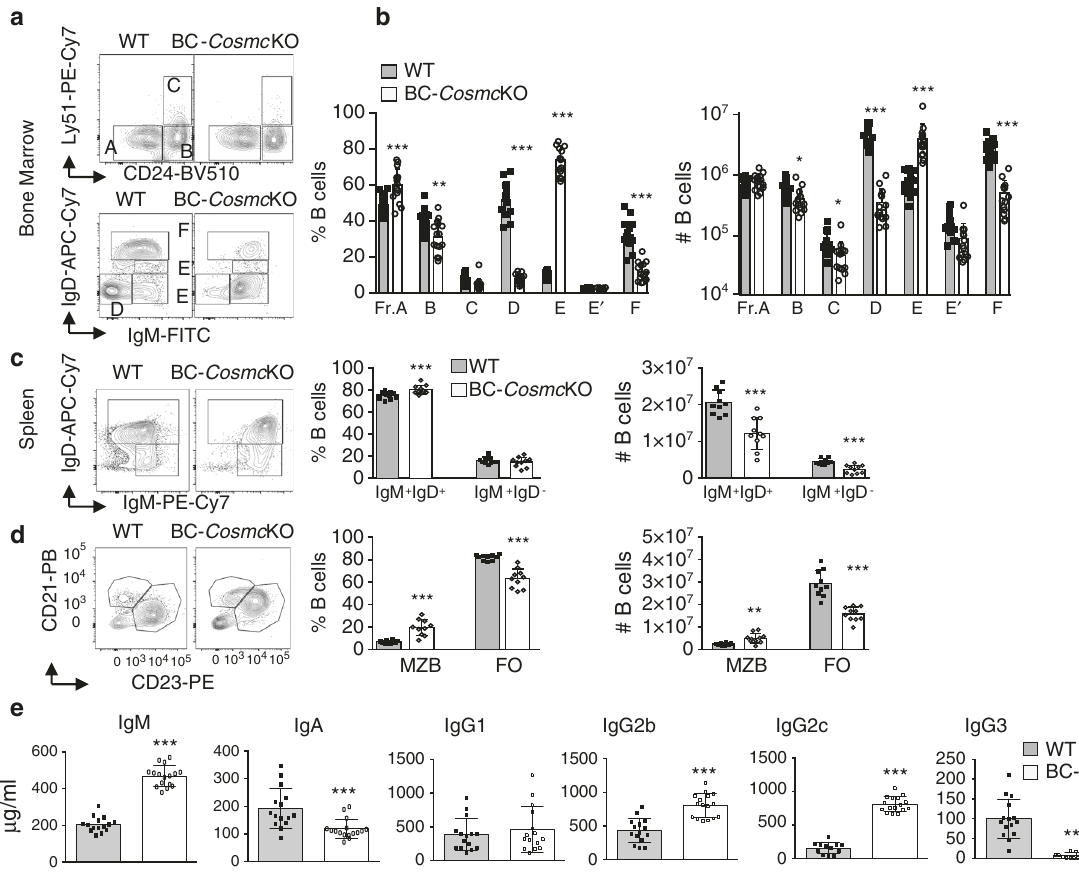
Fig. 2 Cosmc is required for B cell development. Single cell suspensions were prepared from both bone marrow and spleen of WT and BC- Cosmc KO mice and stained with indicated antibodies. Each symbol (black square and open circle for WT and BC- Cosmc KO, respectively) represents an individual mouse. Representative fl ow cytometric contour plots and numbers of B cell subsets were shown in ( a , b ) bone marrow ( n = 16 for WT and n = 15 for BC- Cosmc KO mice), in %B cells bar graphs: p values of fraction ( a ) 0.0003, ( b ) 0.0032, ( c ) 0.0717, ( d ) <0.0001, ( e ) <0.0001, ( e ′ ): 0.7302, ( f ) <0.0001, in #B cells bar graphs: p values of fraction ( a ) 0.2217, ( b ) 0.0167, ( c ) 0.0148, ( d ) <0.0001, ( e ) <0.0001, ( e ′ ): 0.0093, ( f ) <0.0001, and ( c , d ) spleen ( n = 13 for WT and n = 14 for BC- Cosmc KO mice for c , and n = 11 for WT and n = 10 BC- Cosmc KO mice for d . In %B cells bar graphs of c : p values of IgM + IgD + = 0.0003,